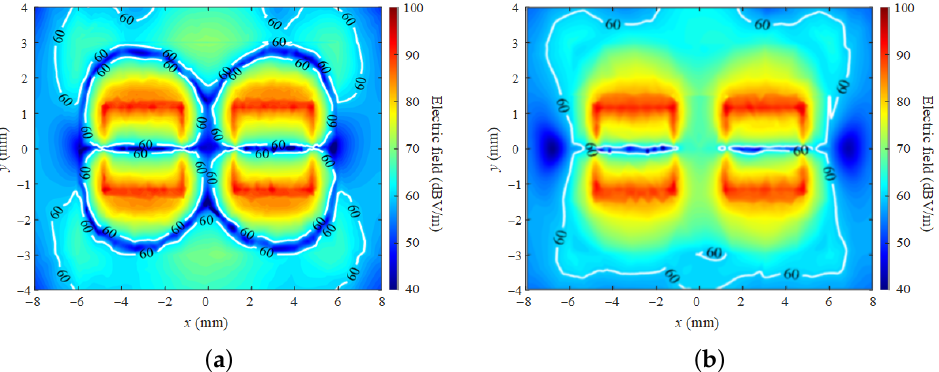
Figure 3. The E-field distributions for the 2 × 1 array antenna: ( a ) with the ASIWC structure, ( b ) without the ASIWC structure.